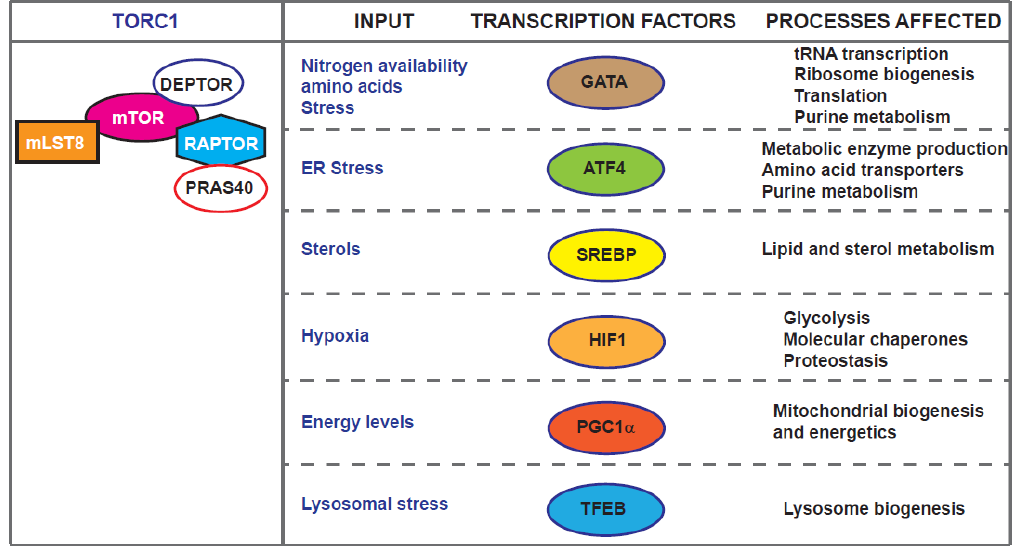
Figure 2. Transcription factors downstream of TORC1, input linked to their action and cellular processes affected.